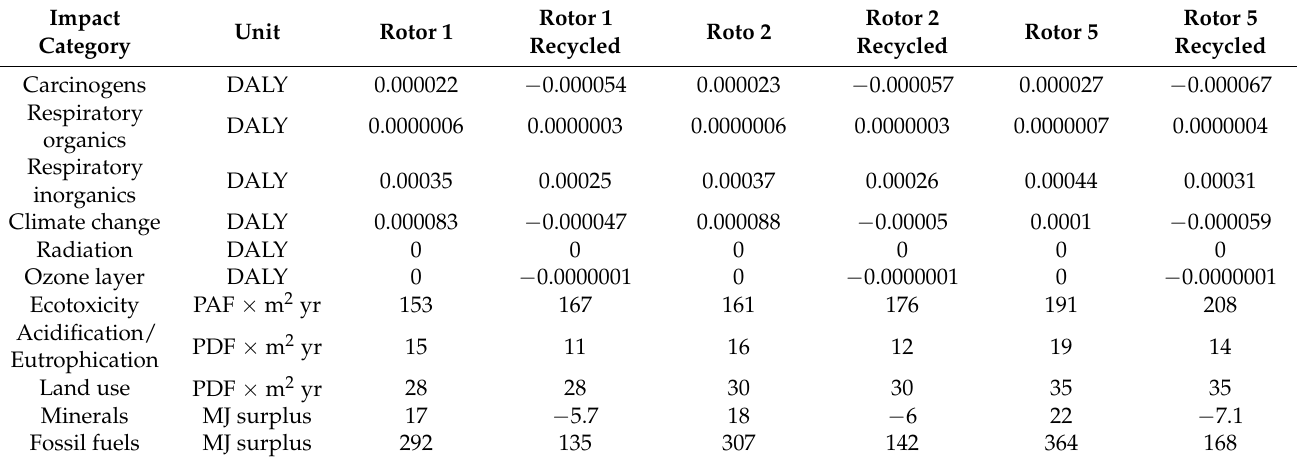
Table 7. Results of characterization of environmental impacts at the manufacturing and recycling stage of the rotors of an innovative wind turbine.